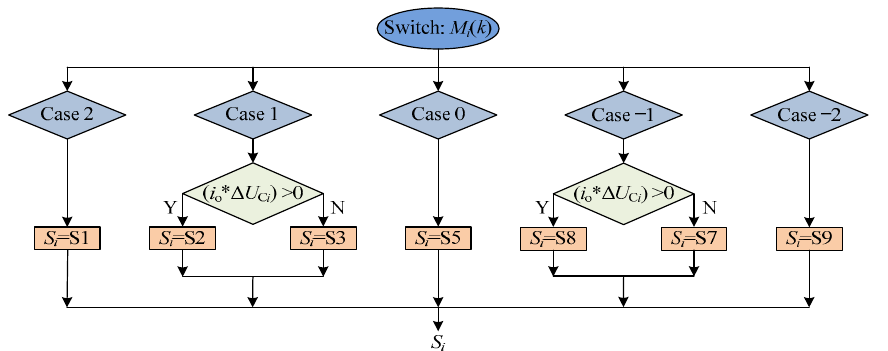
Figure 6. Flow chart of the switching state selection process.